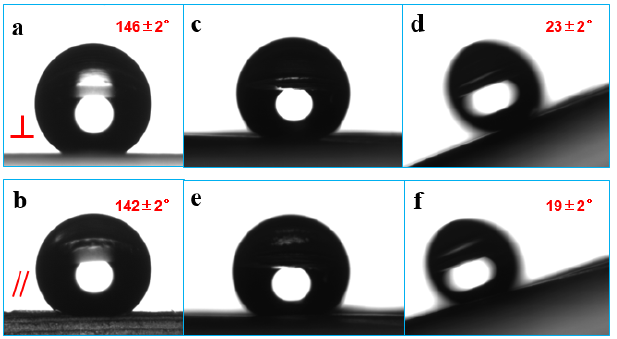
Figure 8. Photographs of the wettability of the artificial PCL surface. ( a , b ) The WCAs along the perpendicular and parallel vein directions; ( c , d ) the WSA along the perpendicular vein direction; and ( e , f ) the WSA along the parallel vein